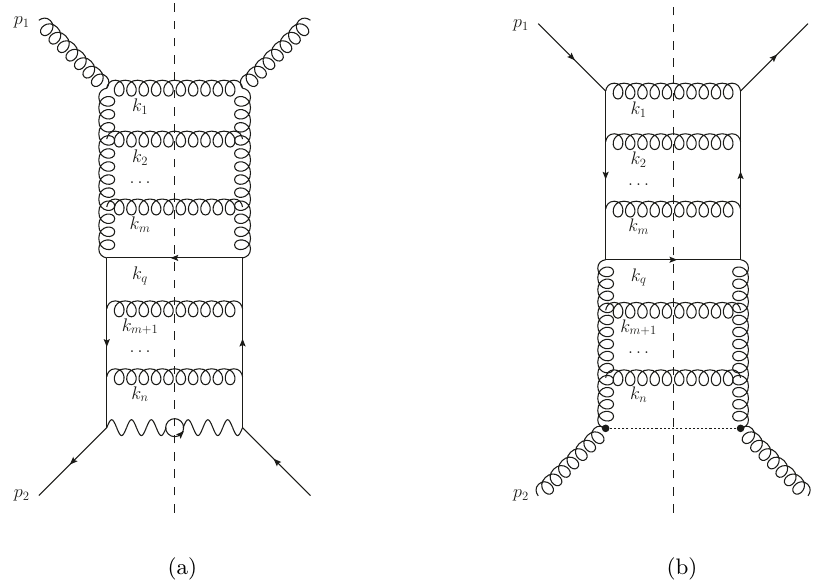
Figure 6. (a) Ladder diagram contributing to the g ¯ q channel in DY production; (b) similar but for the qg channel in Higgs